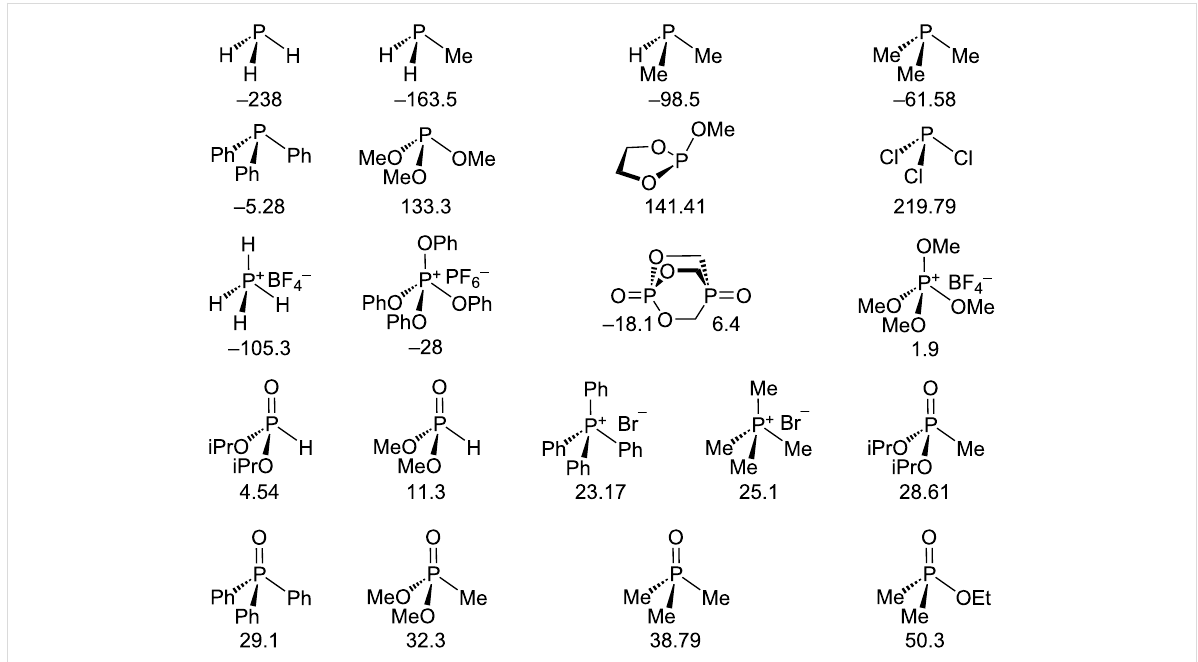
Figure 1: Training set of tri- and tetracoordinate phosphorus compounds; chemical shifts are in ppm, referenced to external 85% H 3 PO 4 at 0 ppm (positive values downfield of H 3 PO 4